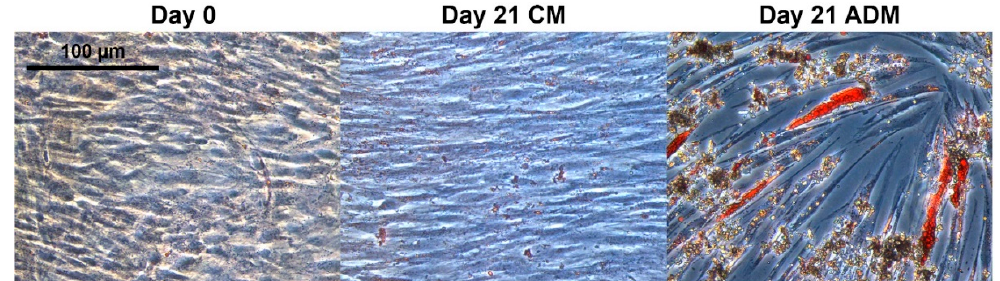
Figure 1. Oil Red O staining of adipose tissue-derived mesenchymal stem / stromal cells (MSCs) after 0 and 21 days cultivation in the adipogenic di ff erentiation medium (ADM) or control medium (CM). The scale bar indicates 100 µ